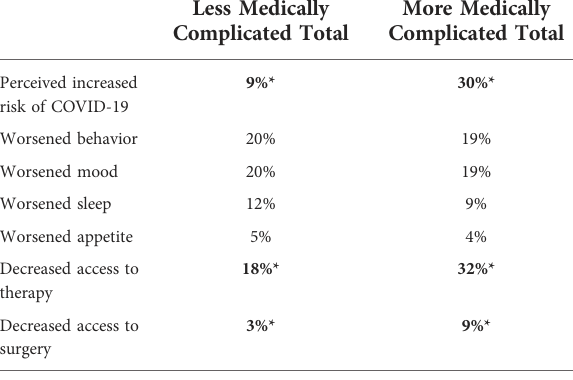
TABLE 3 Comparison of more medically and less medically complicated clinics by pandemic questionnaire item. Less